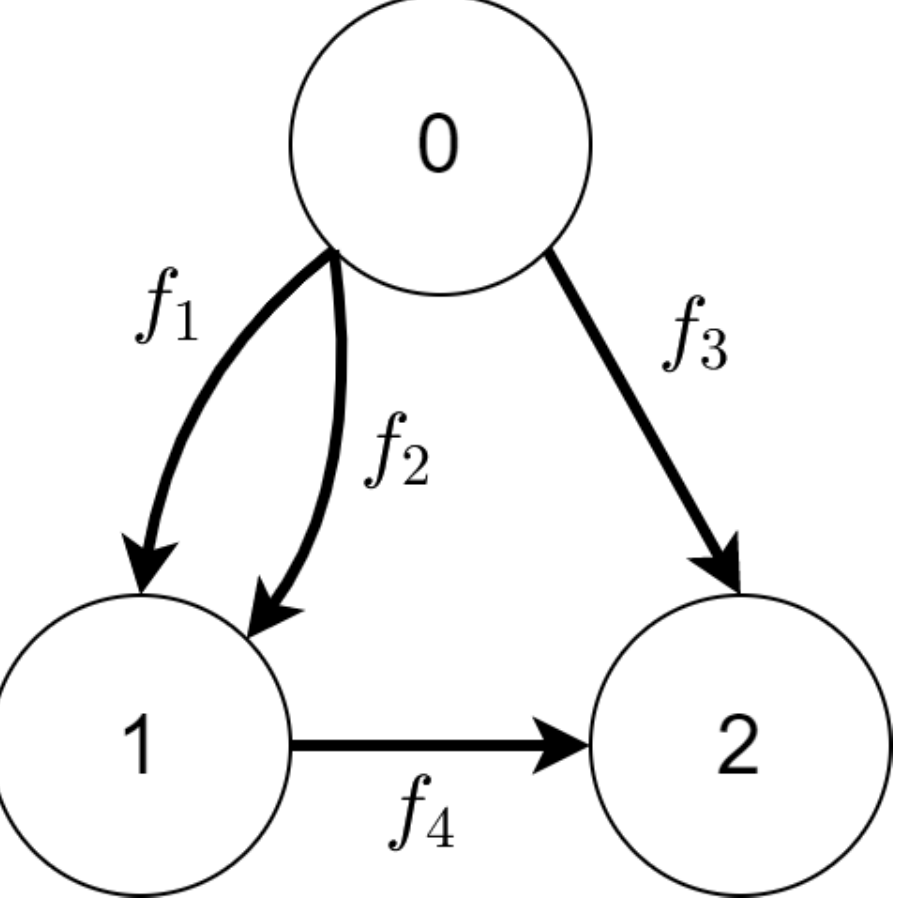
Figure 4. The state space generated from Tracking Transition System defined in Table 1. Mission progress functions definitions are defined in Table